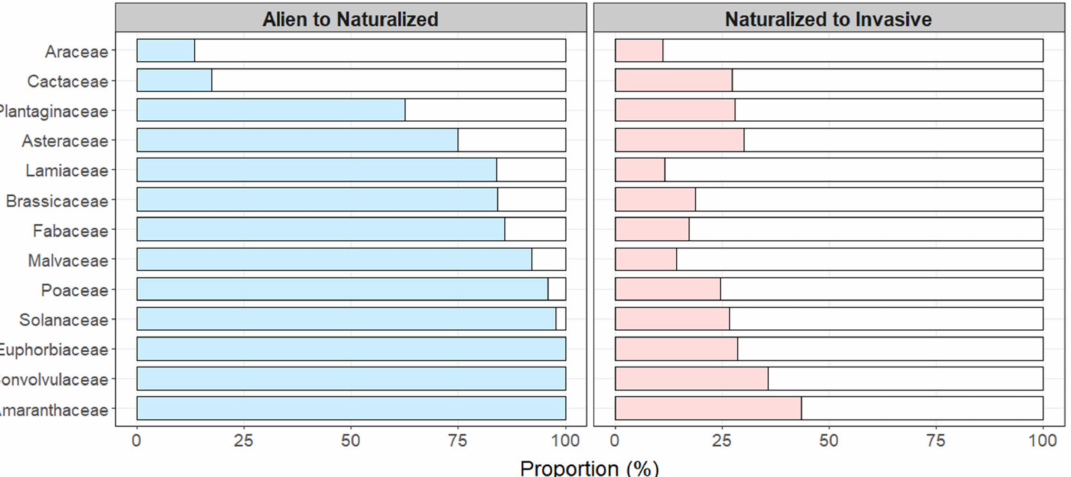
Figure 2. Proportion of species in dominant families that have transitioned from alien to naturalized status, and from naturalized to invasive status.